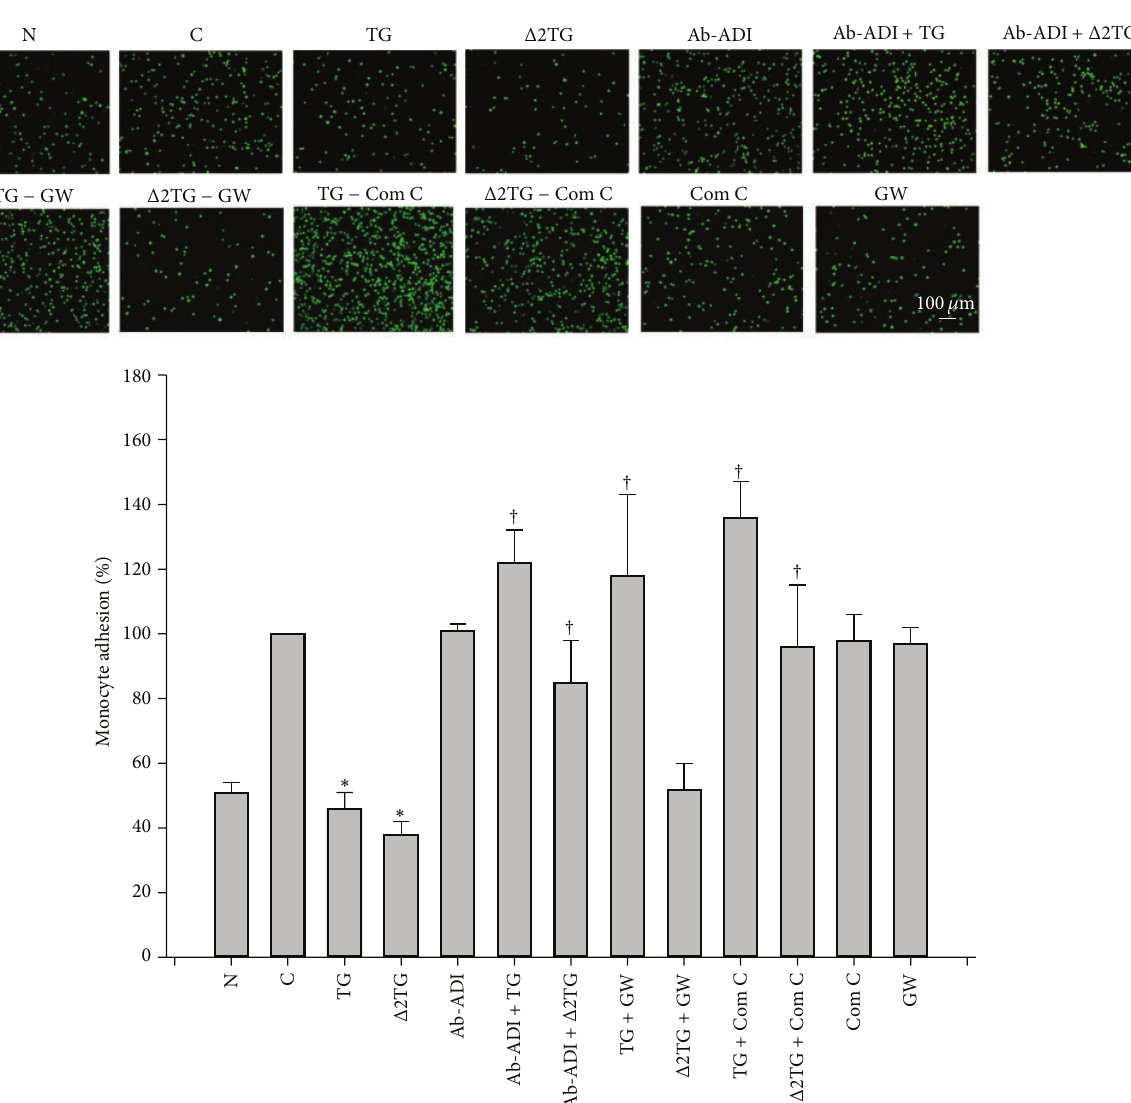
Figure 7: TG and Δ 2TG reduced the adhesion of THP-1 cells to TNF- 𝛼 -treated HUVECs. HUVECs were pretreated for 4h with 3 ng/mL of TNF- 𝛼 . THP-1 cells were left untreated or were pretreated for 1h with 0.2 𝜇 g/mL of purified antiadiponectin antibody (Ab-ADI) and then with 9 𝜇 M TG or with Δ 2TG for 18 h. In addition, THP-1 cells were left untreated or were pretreated for 1h with 5 𝜇 M GW9662 (GW) or 0.625 𝜇 M compound C (Com C) and then with 9 𝜇 M TG or with Δ 2TG for 18 h in the continued presence of the inhibitor. The BCECF/AM-labeled THP-1 cells were added to TNF- 𝛼 -treated HUVECs in a 24-well plate and incubated for 1h, and then the nonadherent cells were removed by two gentle washes with PBS and the number of bound monocytes counted by fluorescence microscopy. N represents HUVECs without any treatment. C represents HUVECs with TNF- 𝛼 treatment. ∗ 𝑃 < 0.05 as compared to the C cells. † 𝑃 < 0.05 as compared to TG-treated cells and Δ 2TG-treated cells, respectively. Bar = 100 𝜇